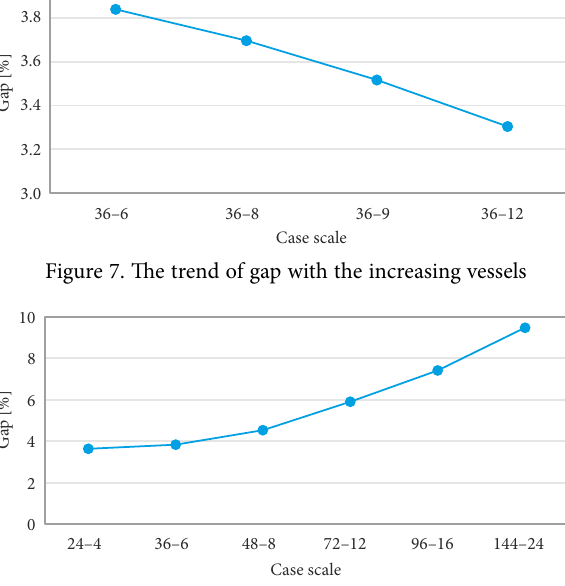
Figure 8. The trend of gap with the increasing subblocks and vessels